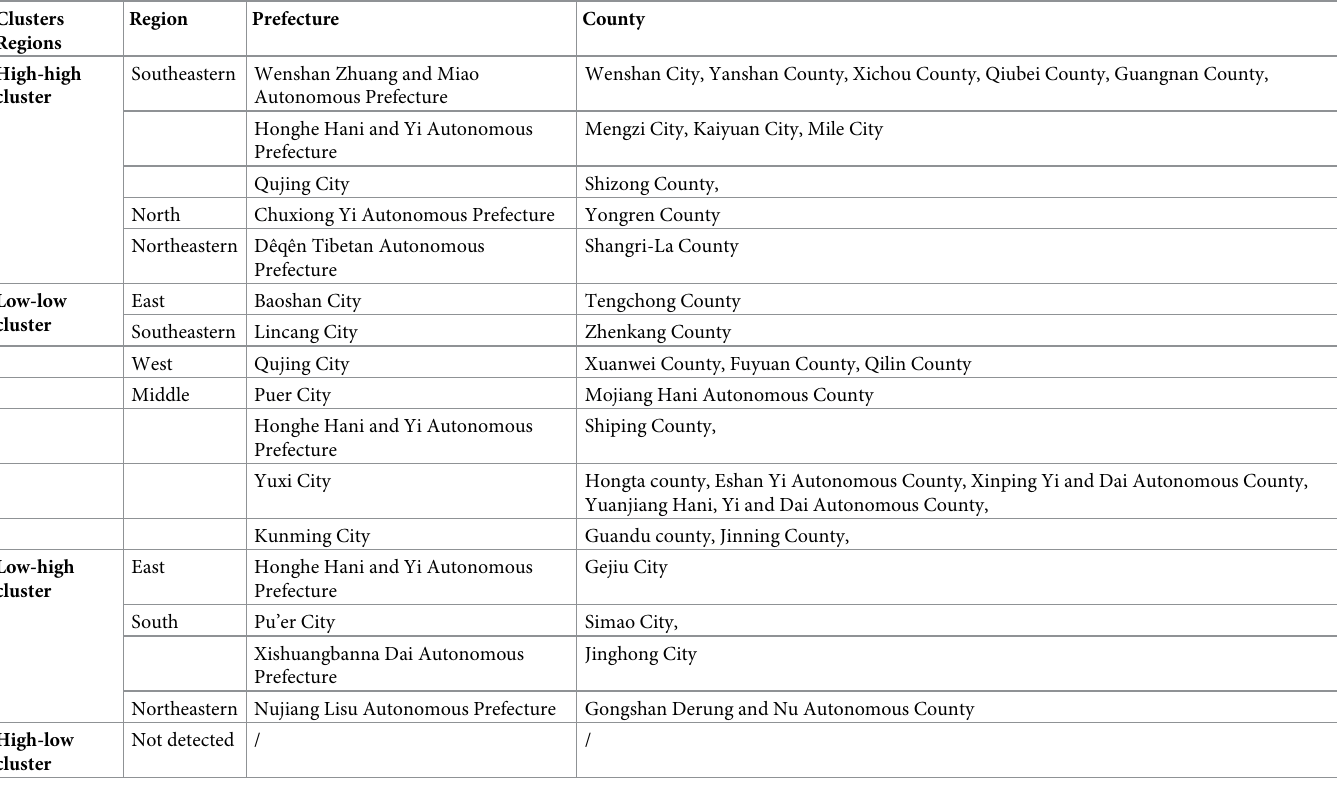
Table 4. The result of local spatial autocorrelation analysis of new detected leprosy cases in Yunnan, China 2011–2020. Clusters Region Regions